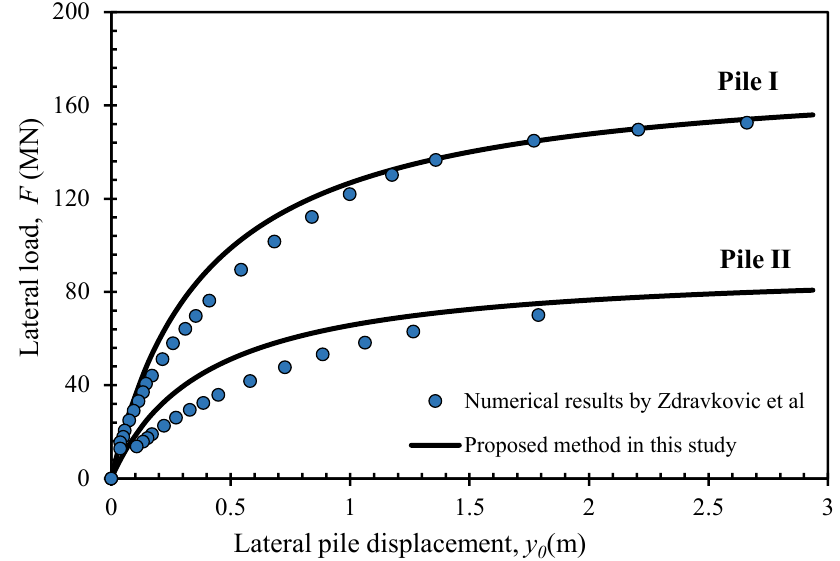
Figure 12. Comparison of monopile head load displacement response for case 3 [33].